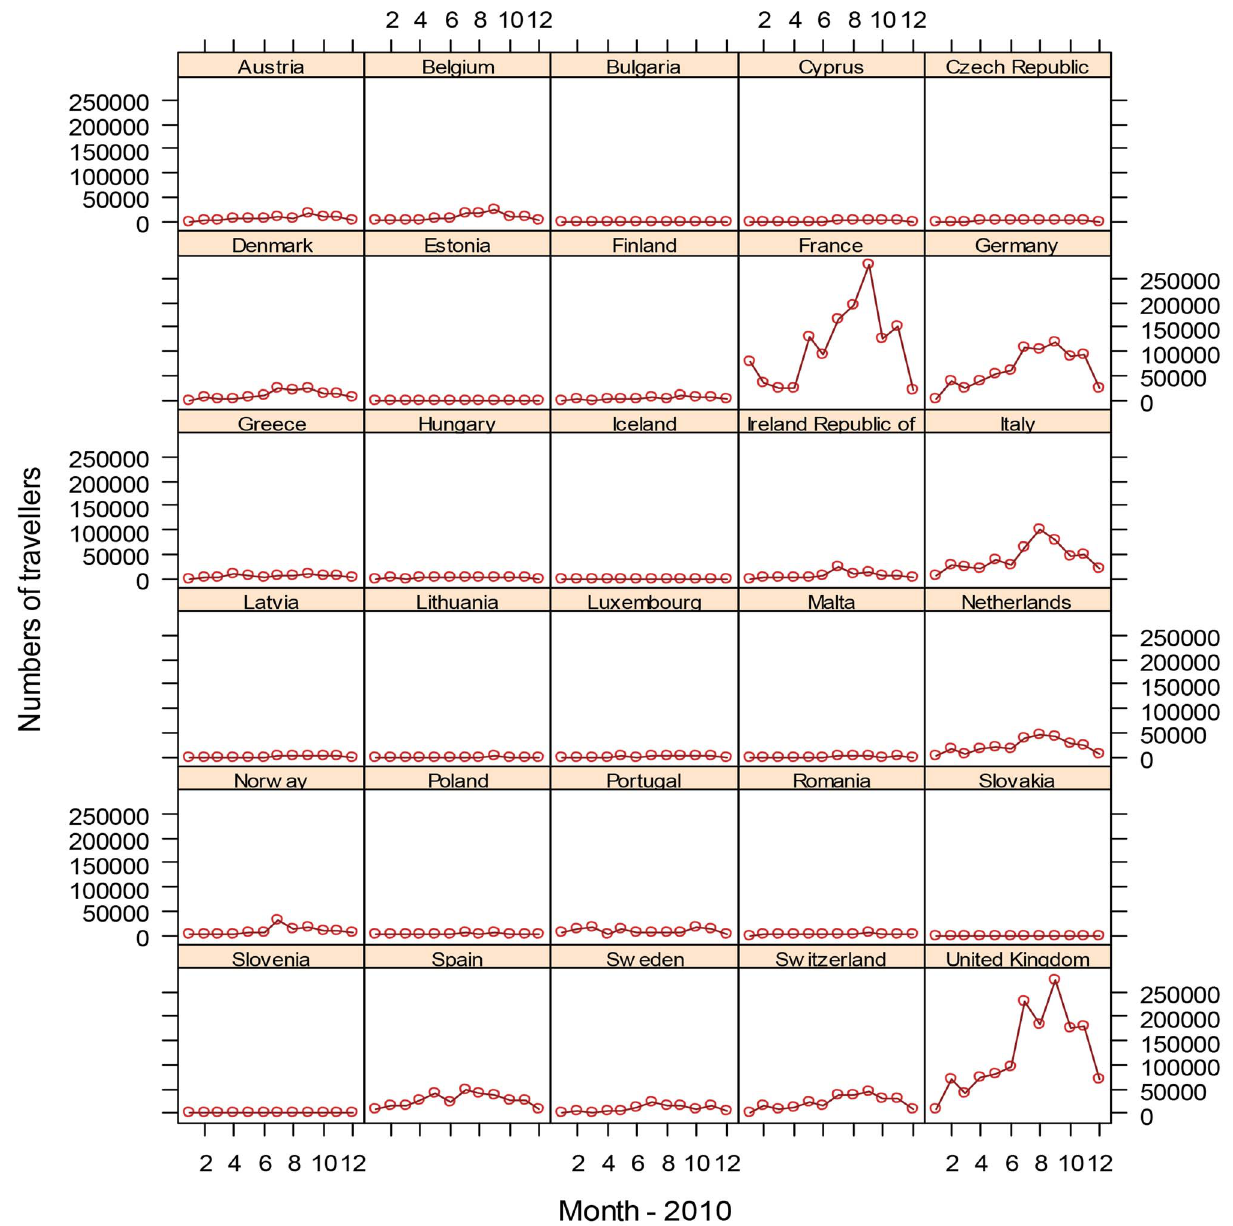
Figure 4. Number of international air travellers from dengue affected areas (endemic and epidemic) arriving in the EU, by country and month, 2010.